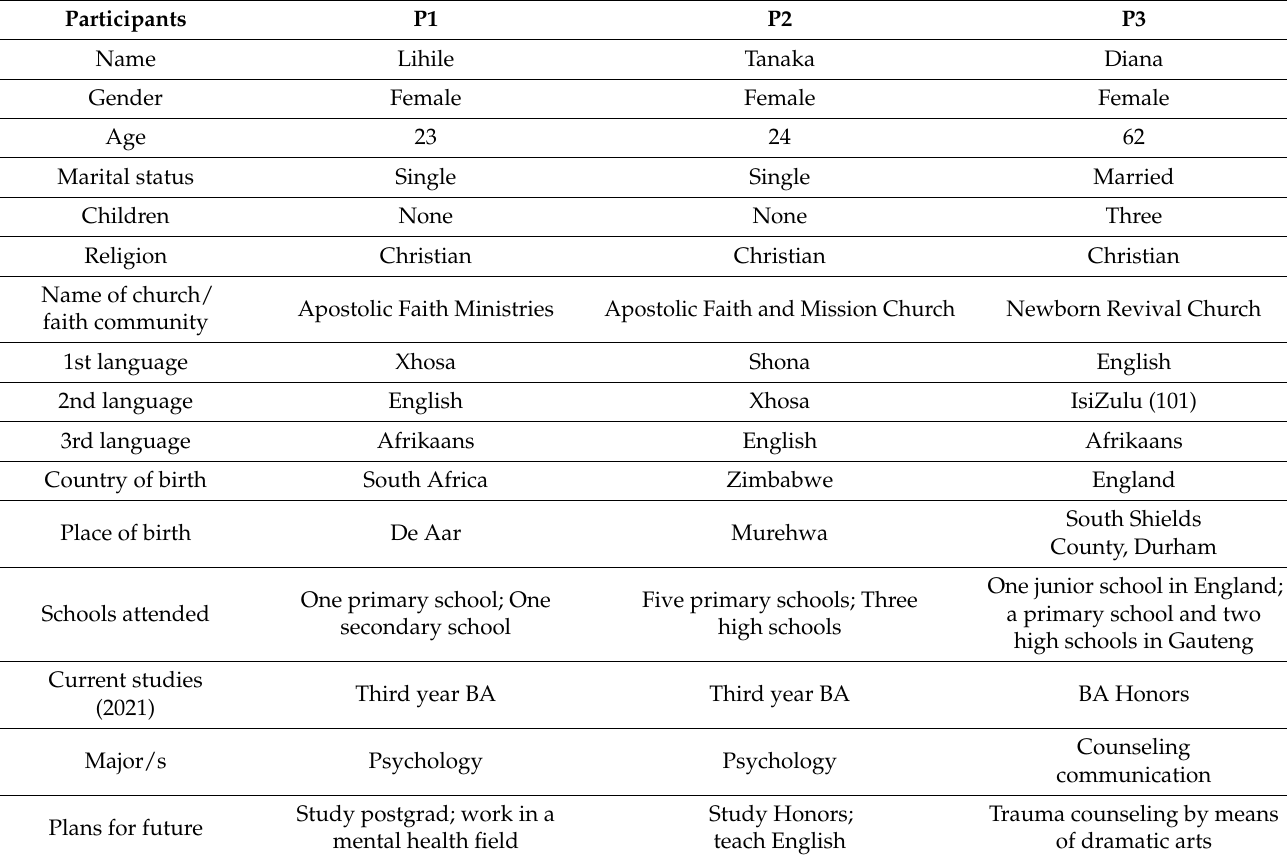
Table 1. Demographics of student